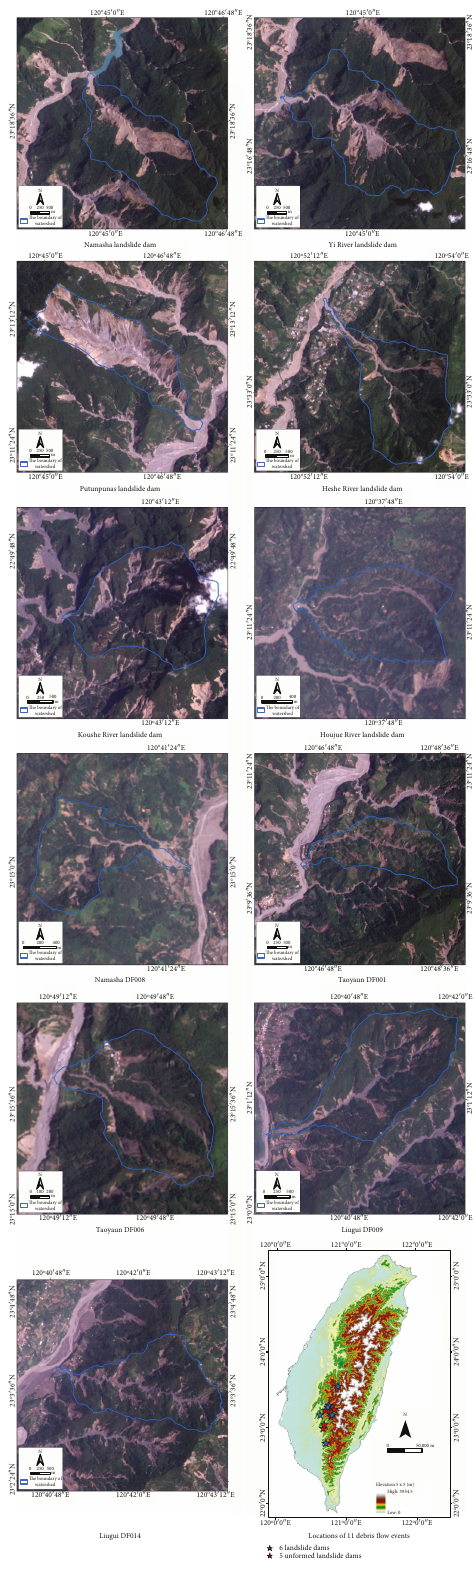
Figure 1: Locations and images of 6 landslide dam cases and 5 unformed landslide dams in this study (FORMOSAT-2 Image, Aug.